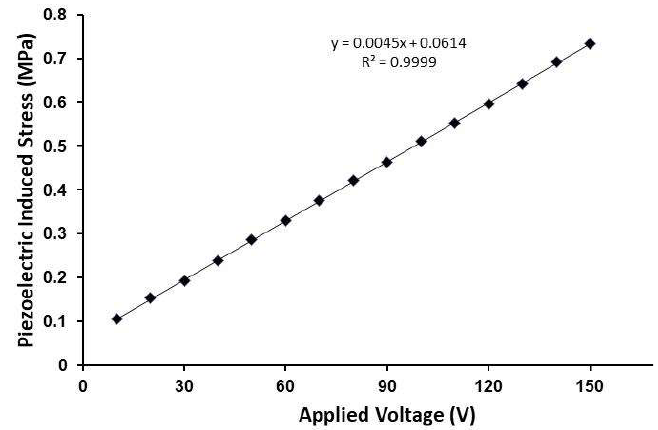
Figure 6. Variation of the induced stresses by the piezoelectric patch as a function of applied voltage.